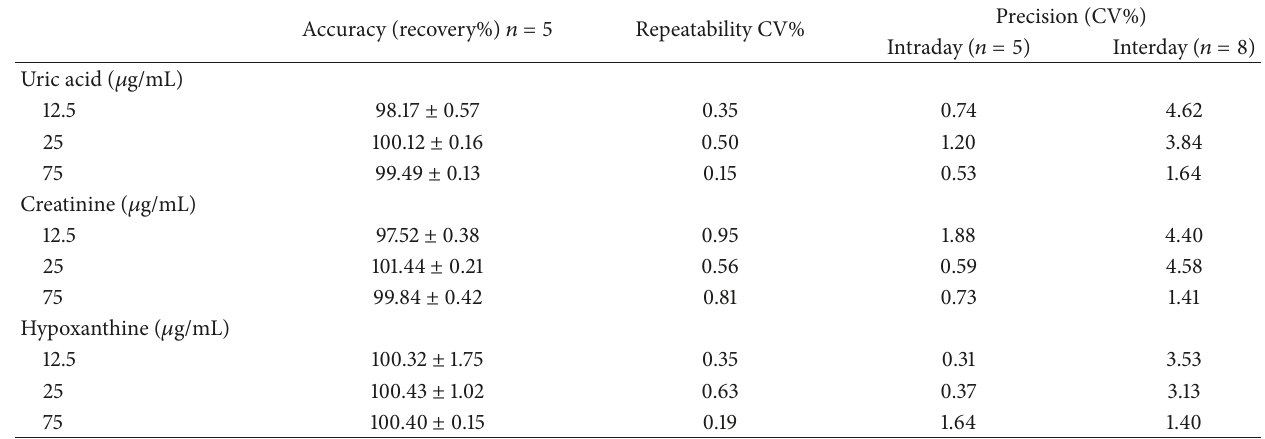
Table 2: Accuracy, repeatability, and precision for uric acid, creatinine, and hypoxanthine.